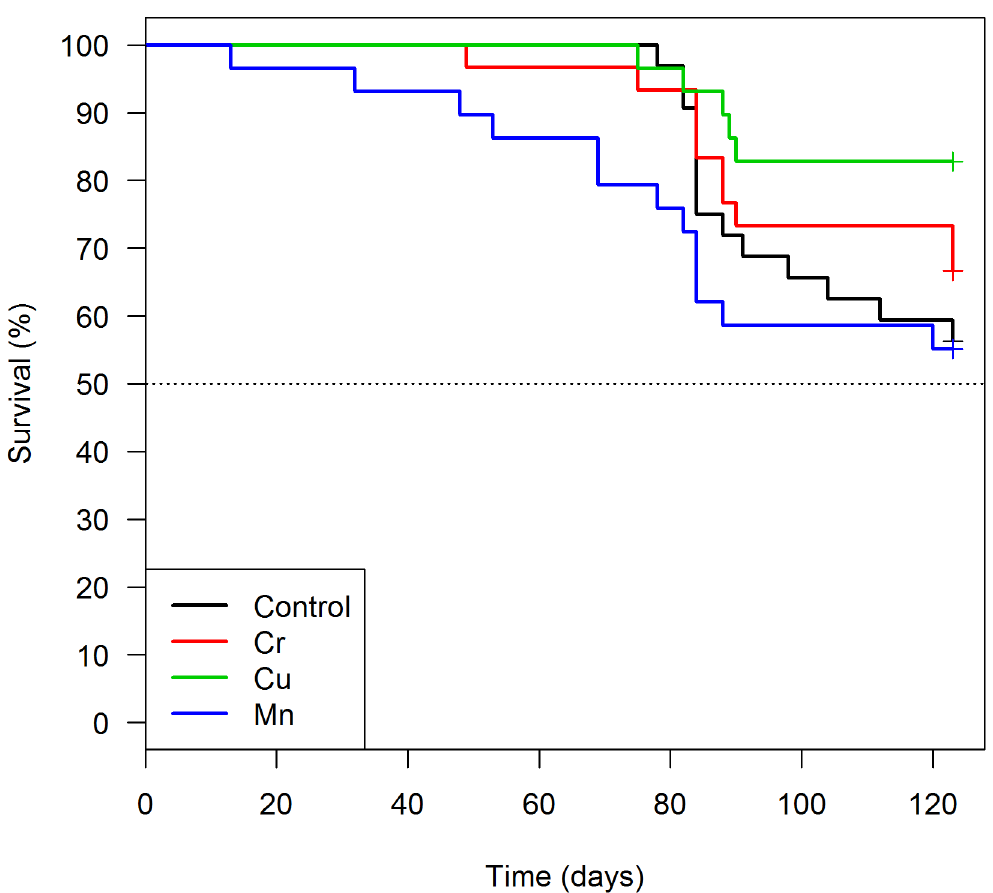
Fig 3. Survival analysis of Triatoma pseudomaculata fed with sheep blood enriched with one of the following trace elements: Cr (N = 30), Cu (N = 29), Mn (N = 29) and control group (N = 32).